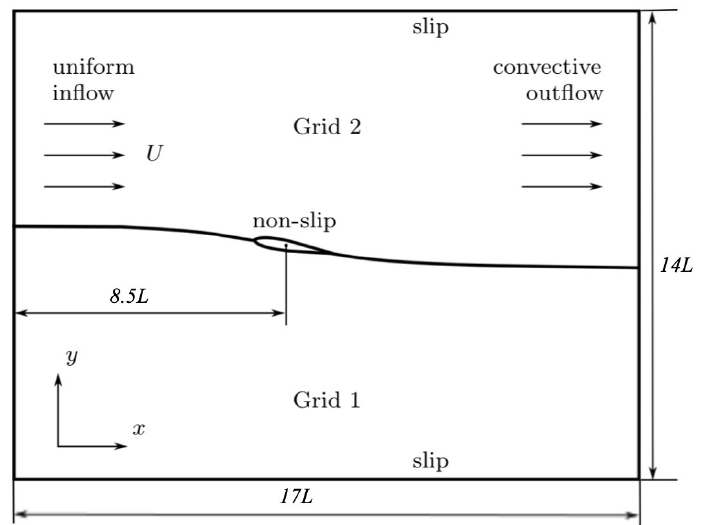
Figure 5. Computational domain and boundary